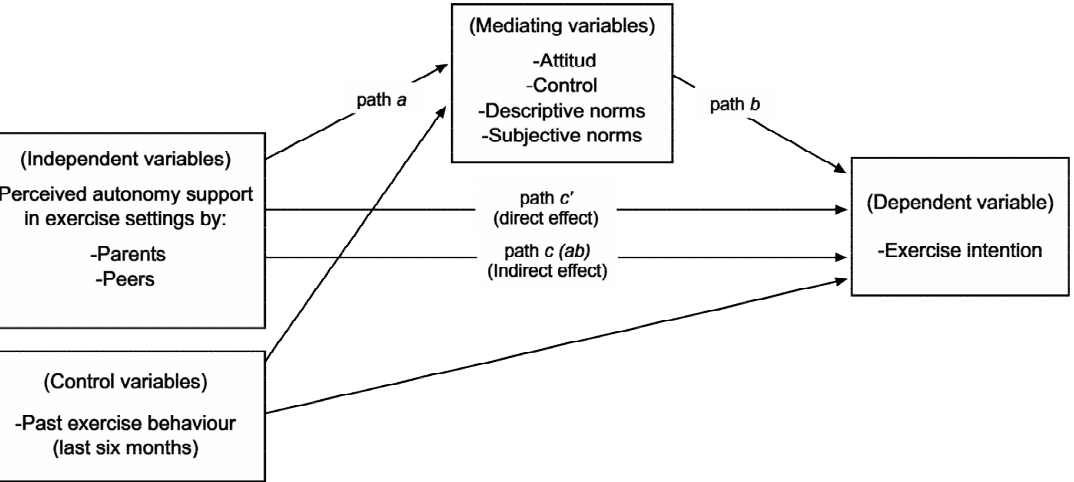
Figure 1. Mediation model tested.